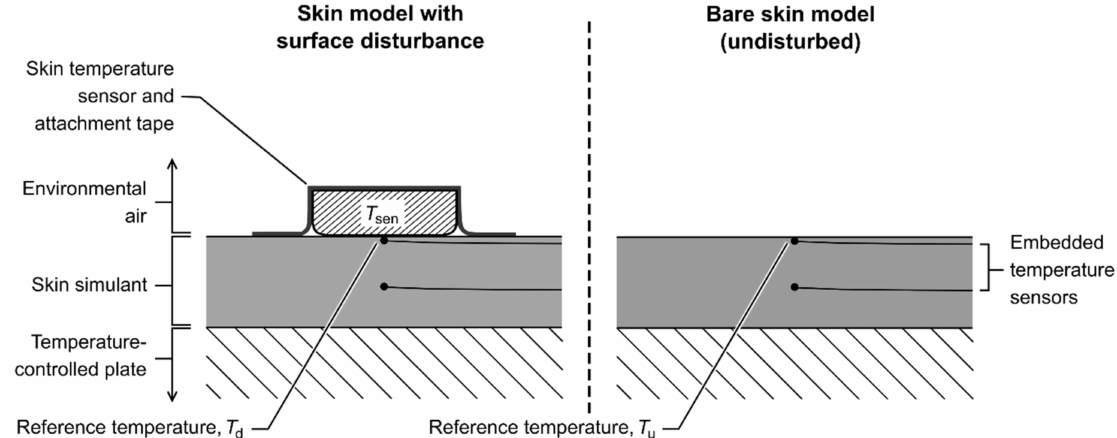
Figure 1. Cross-section of the skin model at the measurement site, showing the surface position of the skin temperature sensor and/or tape when used (left) and the same section of the model in the state ‘unmeasured’ by the skin temperature sensor (right). The top embedded temperature sensor (directly subsurface) was used as the reference surface temperature, becoming the disturbed reference temperature ( T d ) when a surface skin temperature sensor was present (left) and the undisturbed reference temperature ( T u ) when the model surface was bare (right). This setup enabled characterization of the relationships among the temperature of the surface skin temperature sensor ( T sen ), T d , and the corresponding T u under otherwise equivalent